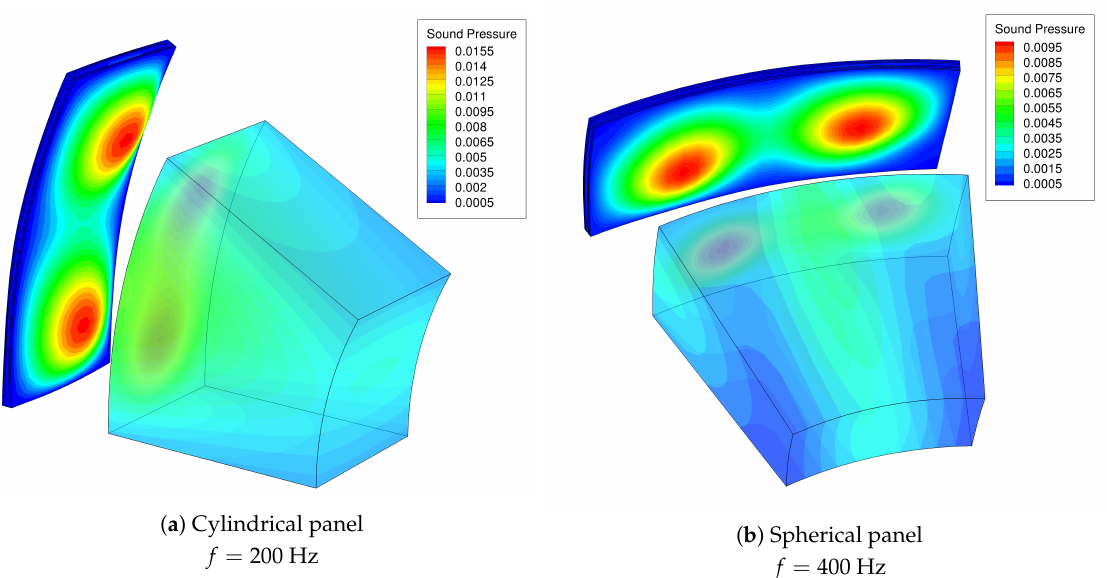
Figure 13. Composite rectangular cylindrical and spherical shells with R α = R β = 3 m and lamination [ 0 ◦ /45 ◦ /90 ◦ / visco ] S . Three-dimensional representation of the Sound Pressure (Pa) emitted by the shell panels from the bottom shell surface to a radial distance of 1